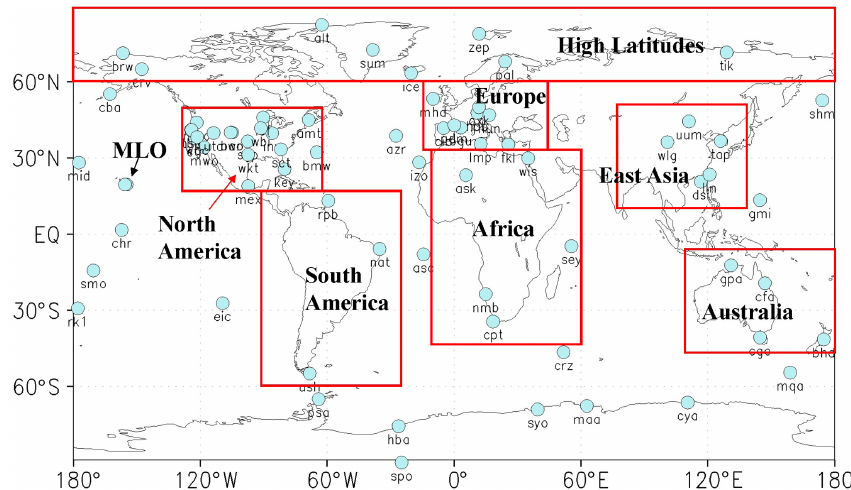
Figure 1. Distributions of the surface flask observation sites used in this study.